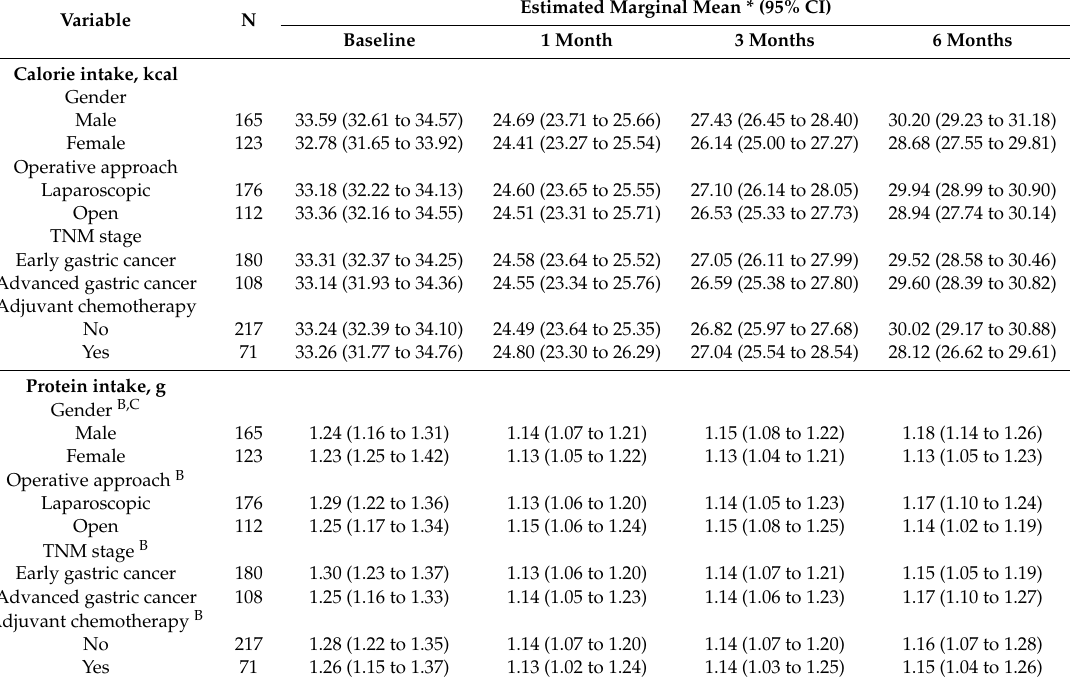
Table 3. Change in calorie and protein intake after gastrectomy according to the clinical factors. Estimated Marginal Mean * (95% CI) Variable N Baseline 1